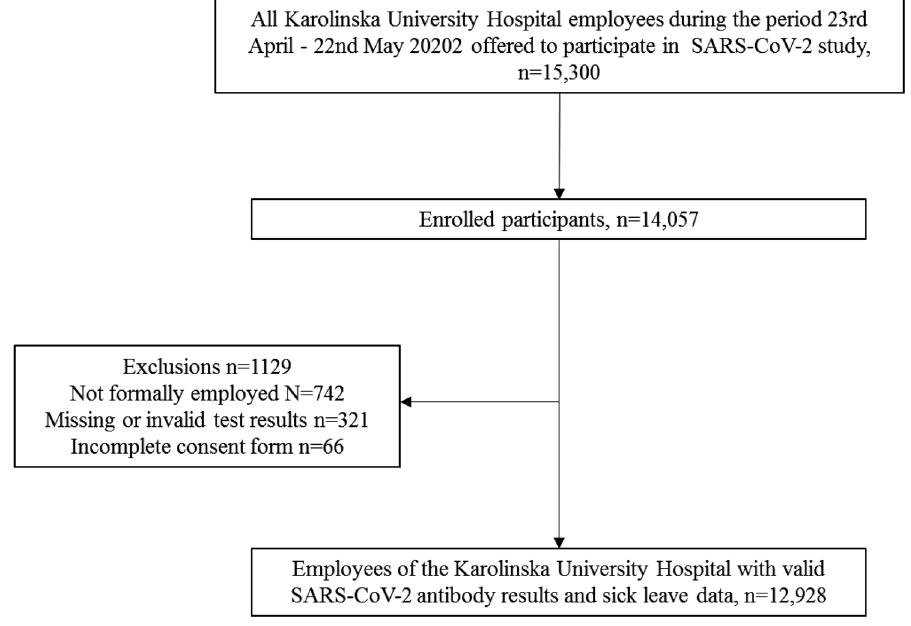
Figure 1. STROBE flowchart of study participants.